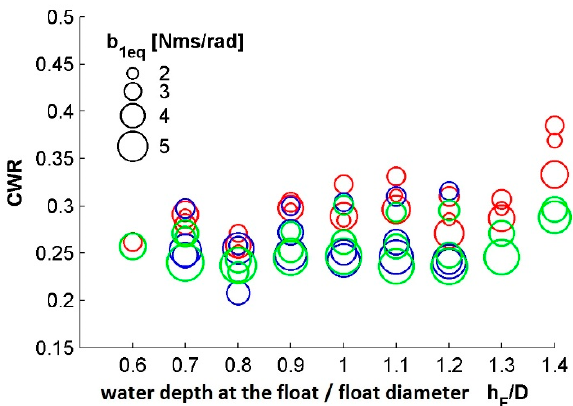
Figure 11. CWR of EDS as a function of flat damping b 1eq , distance between paddle and float d P-F / D , water depth at the float h F / D . Red circles, d P-F /D = 0.8; blue circles, d P-F /D = 1.1; green circles d P-F /D = 1.4. Wave C.